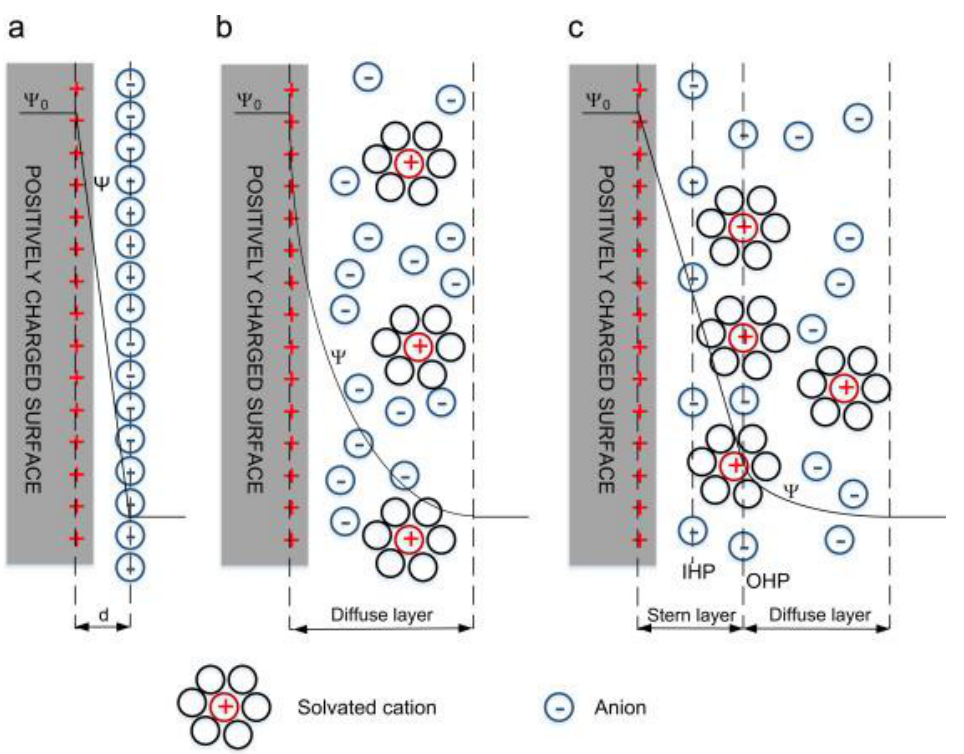
Figure 2. Schematic illustration of the charging process ( a ): charged state ( b ), discharging process ( c ) [26].